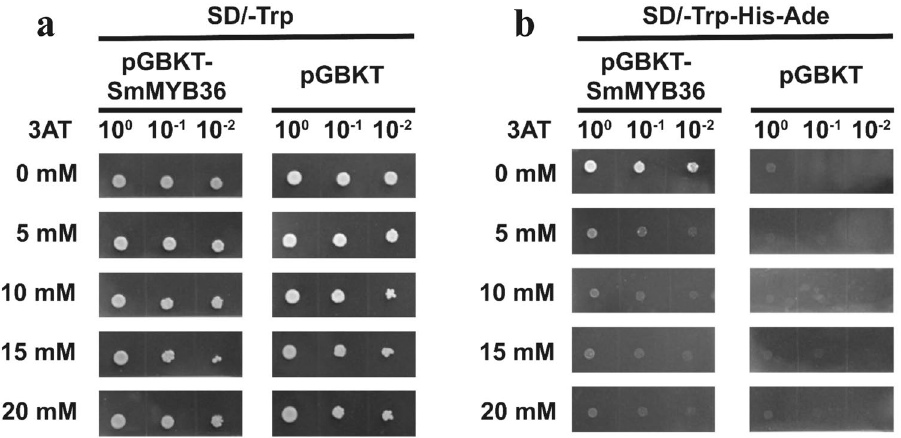
Figure 4. The transactivation analysis of SmMYB36. ( a ) The yeast AH109 containing pDEST-GBKT7 or pDEST-GBKT7-SmMYB36 construct could survive on SD/-Trp medium regardless of the concentration change of 3AT (from 0 mM to 20 mM). ( b ) While on SD/-Trp/-His/-Ade medium, only the yeast with pDEST-GBKT7- SmMYB36 plasmid grew normally in the absence of